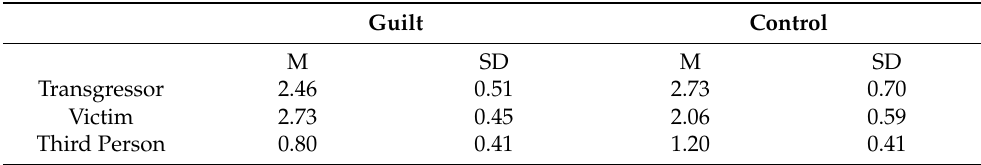
Table 1. Means and standard deviations of the lottery tickets distribution among the three individuals in each condition of Experiment